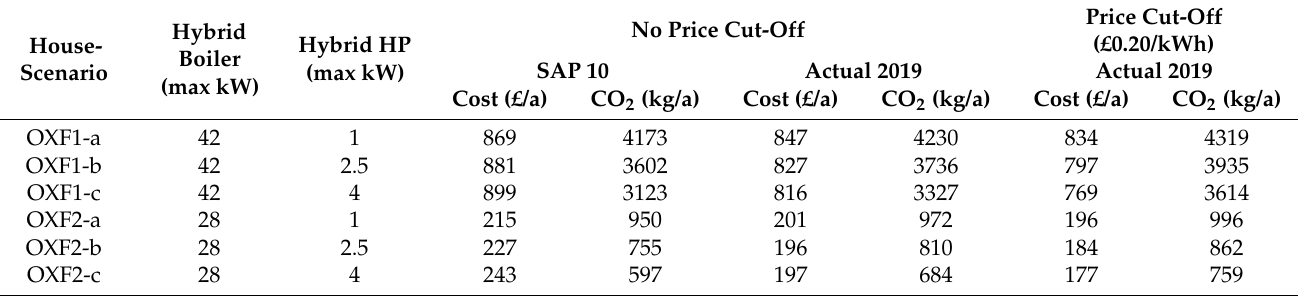
Table 3. Cost and CO 2 results for hybrid heat pump of various sizes in OFX1 and OXF2. Results are given without a price cut-off, using SAP 10 prices and emission factors and actual 2019 Octopus Agile and 2019 half-hourly grid emission factors. Results are also given for the case where the HP does not switch on when the price is over £0.20/kWh for electricity, based on Octopus Agile 2019 and actual 2019 half-hourly grid